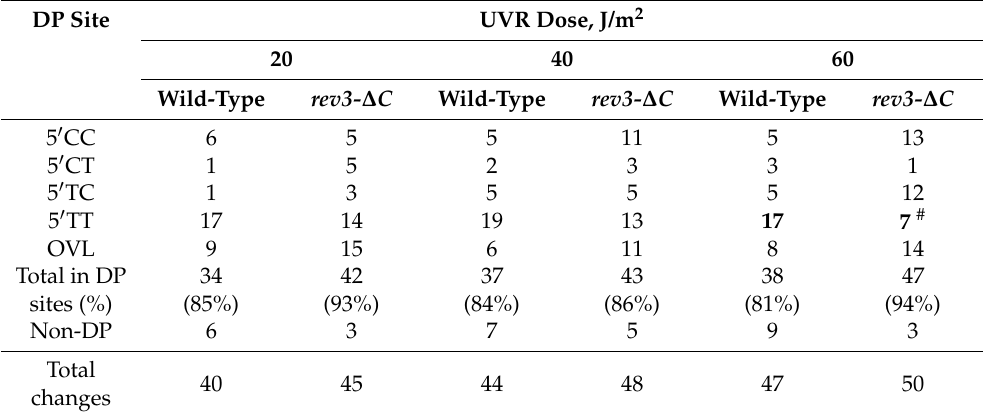
Table 2. UVR- induced mutations occur predominantly in dipyrimidine (DP) sites in wild-type and rev3- ∆ C